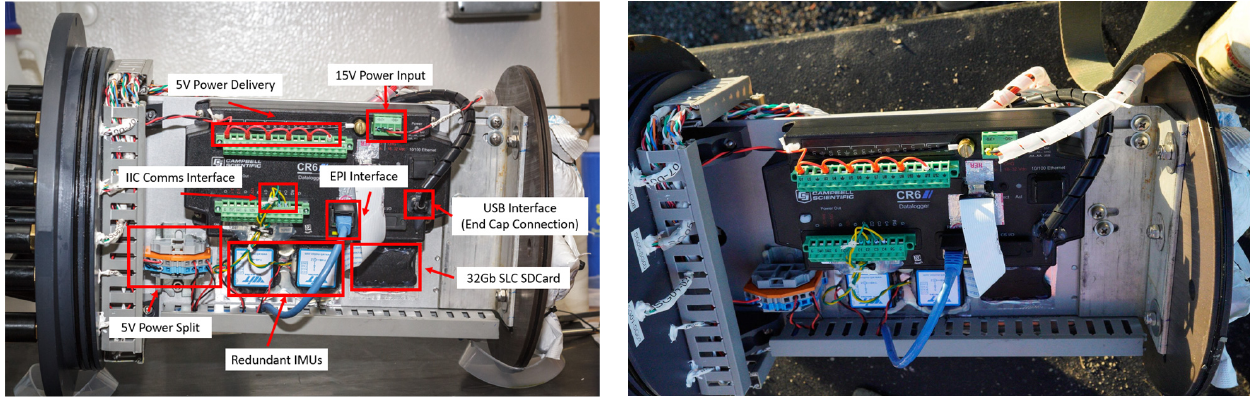
Figure 6. Campbell Scientific data logger ( left ) before deployment and ( right ) after deployment. All components of the system were in “as-deployed” condition once retrieved. No visible damage or unexpected wear of any kind was observed.